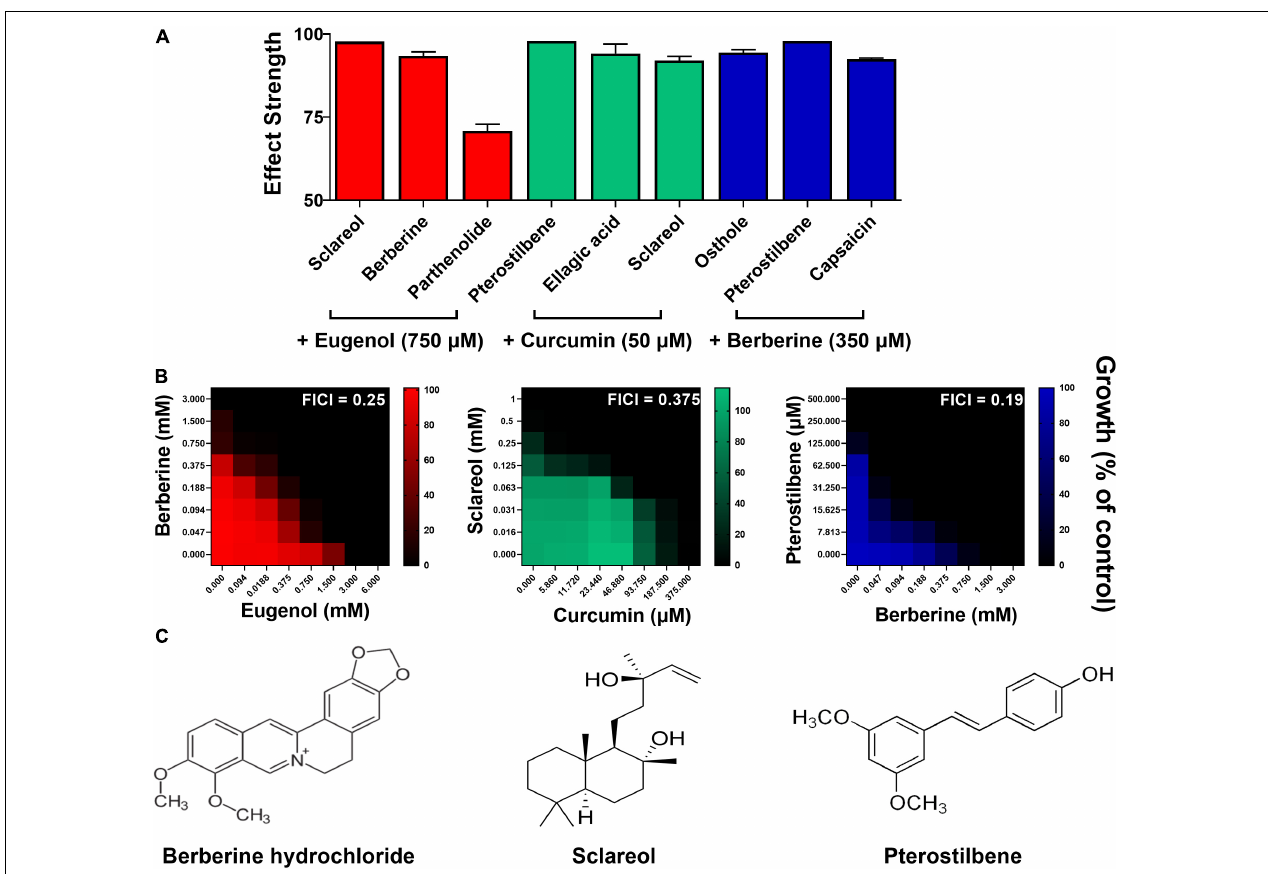
FIGURE 4 | Corroboration of synergies in S. cerevisiae . (A) Mean effect strengths ± SEM from each screen ( Figure 3 ) for selected combinations of interest ( n = 2). (B) Checkerboard assays of combinatorial growth effects performed according to the EUCAST procedure in YPD broth with S. cerevisiae W303 at the indicated concentrations of eugenol, curcumin, berberine, sclareol, and pterostilbene. The growth values represent the mean of three independent experiments calculated as percentages of growth (OD 600 ) with the natural products relative to the minus-NP control, after 24 h growth at 30 ◦ C. FICI, fractional inhibitory concentration index, calculated from the data and where growth < 5% of the control was assigned as no-growth (Hsieh et al., 1993). (C) Chemical structures of library compounds giving the strongest effect strengths from each screen and validated in panel (B) . Checkerboard data for additional combinations are presented in Supplementary Figure 4